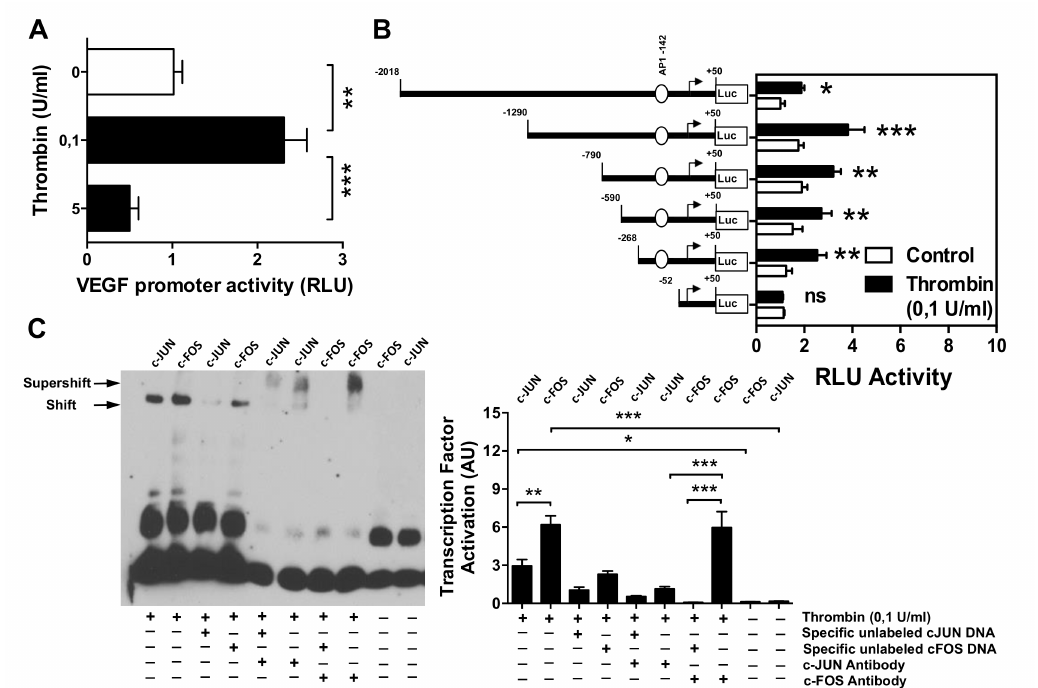
Figure 3. Effect of thrombin stimulation on the VEGF promoter. HMECs were transiently transfected with VEGF promoter constructs, stimulated with thrombin (0.1 U/mL) for 6 h (and 12 h, Figure S1B), and analyzed for luciferase activity. ( A ) Full-length VEGF promoter activity ( n = 5). ( B ) Effect of progressive 5 (cid:48) deletions of the VEGF promoter on its activity upon stimulation with thrombin ( n = 8). ( C ) EMSA identifying the role of c-FOS and c-JUN in mediating VEGF promoter induction by thrombin ( n = 4). Nuclear extracts were obtained from HMECs treated with thrombin (0.1 U/mL) for 6 h, and EMSA was performed using c-FOS and c-JUN consensus oligonucleotide probes either in the presence of an excess of specific unlabeled c-FOS or c-JUN DNA, or in the presence of c-FOS or c-JUN-specific antibodies, with quantification of shift- or supershift lanes, respectively. ANOVA mean +/ − SEM with * p < 0.05, ** p < 0.01, and *** p <